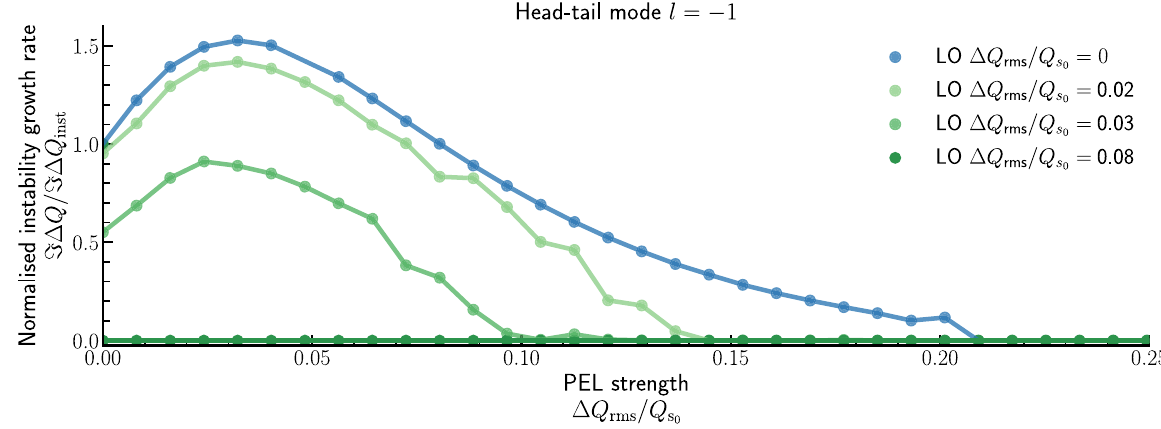
FIG. 12. Landau damping for the head-tail mode l ¼ − 1 due to a combination of LO and a PEL: instability growth rate dependency on the strength of a PEL. The curves correspond to four different LO strengths, given in normalized units in the